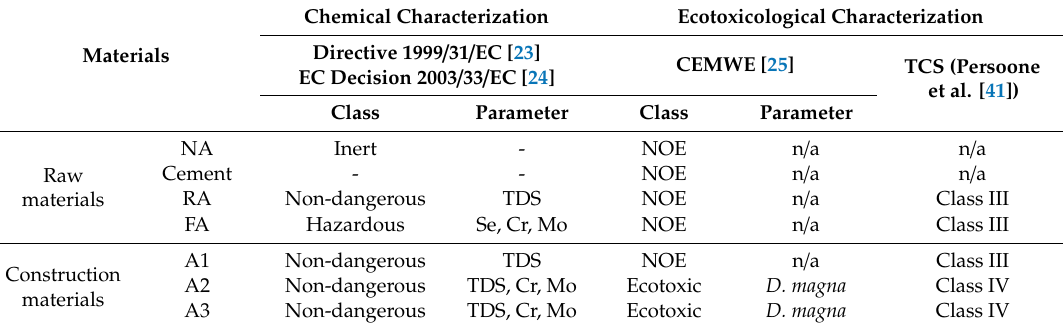
Table 6. Classification of the raw materials and of the concrete mixes according to the EC Decision 2003 / 33 / EC (pursuant to Directive 1999 / 31 / CE), the document of the CEMWE French proposal and the TCS